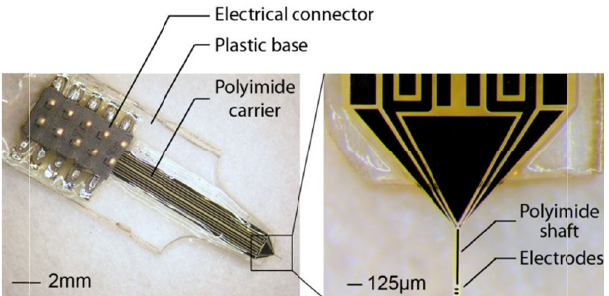
Fig. 2: Photograph of the device used. (Left) The plastic base is used to facilitate attachment to a micromanipulator (not shown) for assisting in precise insertion of the electrodes into the retina. (Right) The narrow polyimide shaft consisting of the electrodes is the part that is inserted in the retina preparation.